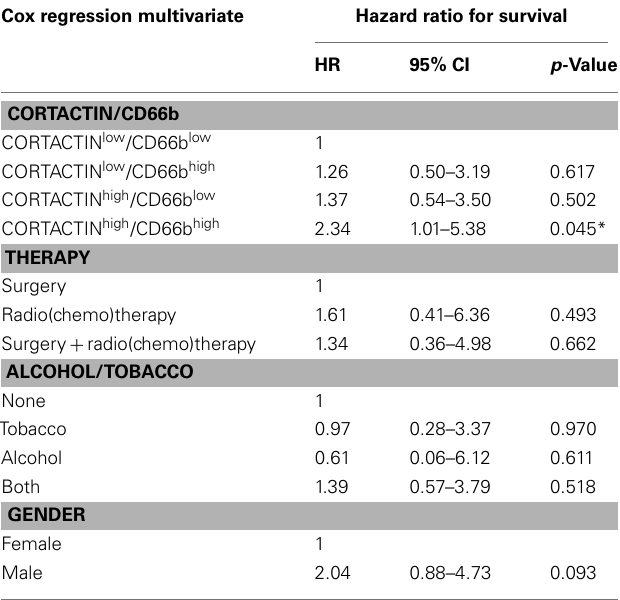
Table 2 | Multivariate Cox regression analysis of CORTACTIN and neutrophilic infiltration adjusted for type of therapy, smoking/alcohol consumption, and